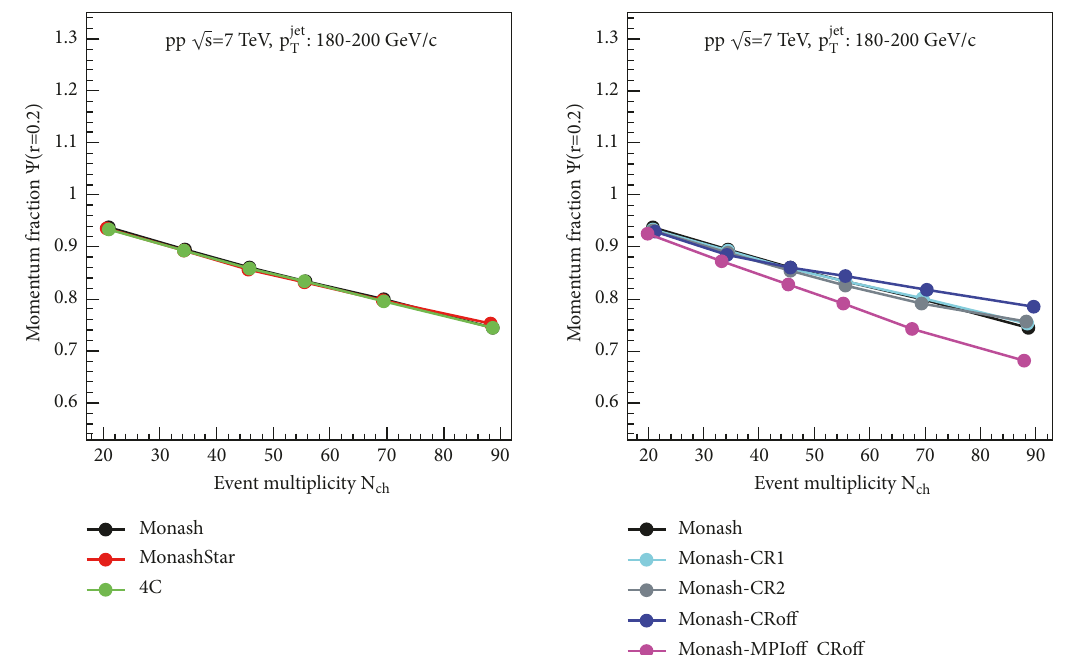
< 200 GeV /𝑐 , with a jet , at 180 GeV /𝑐 < 𝑝 jet ch T